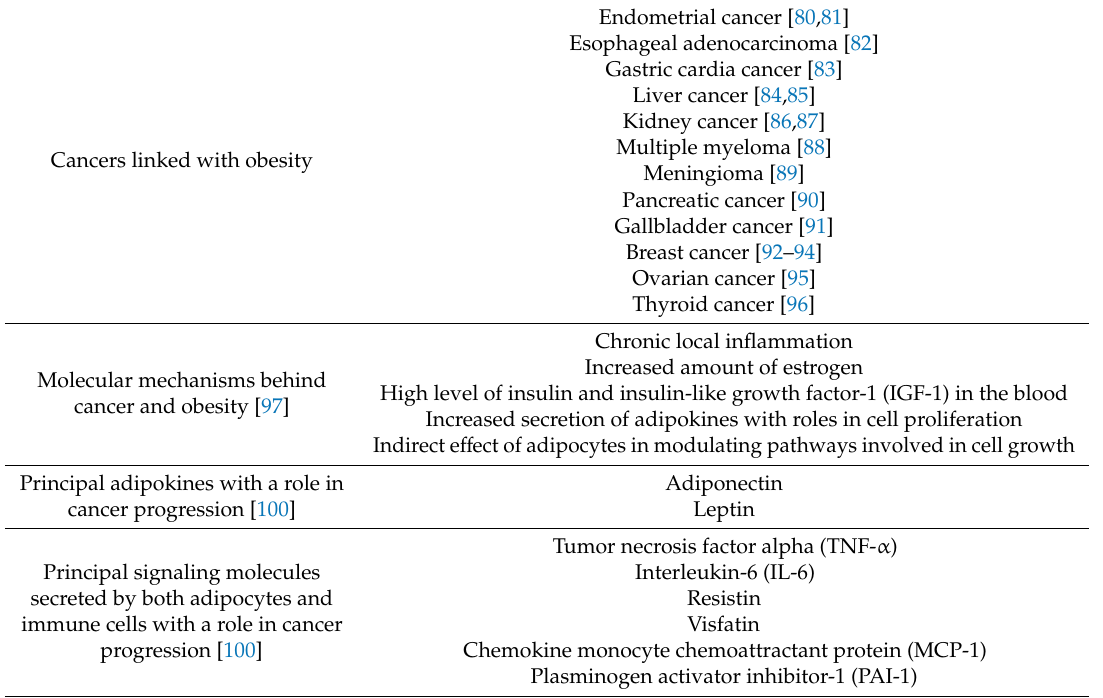
Table 3. Highlights of the connection between adipose tissue and